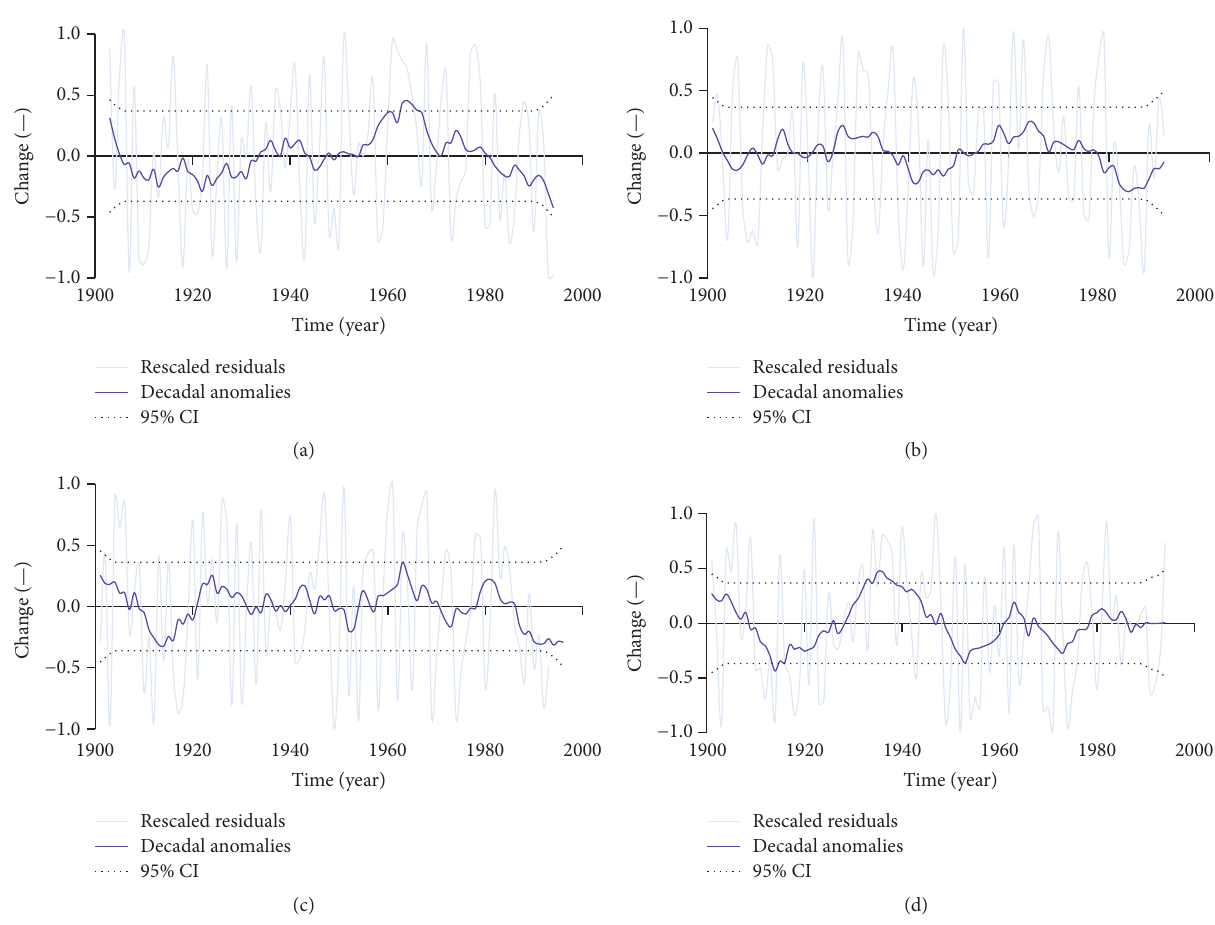
Figure 3: Detrended series and associated variation in decadal anomalies for the annual rainfall at station: (a) 4, (b) 10, (c) 12, and (d) 17.